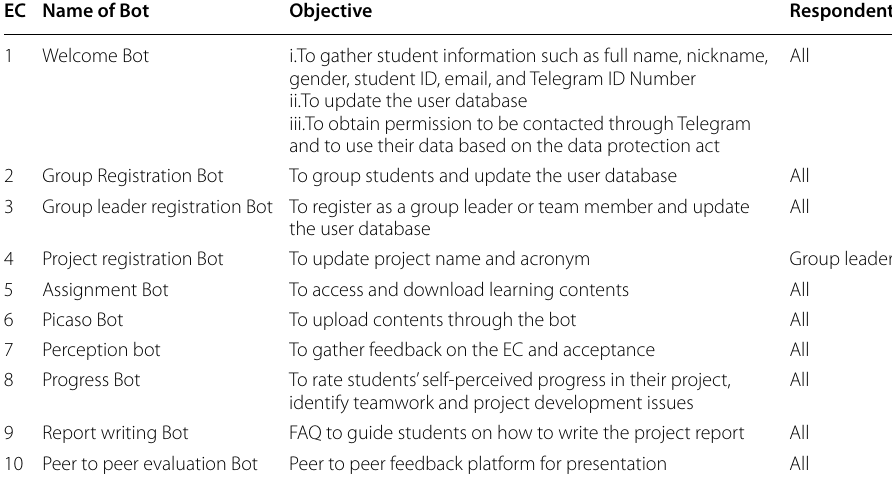
Table 4 Description of ECs and